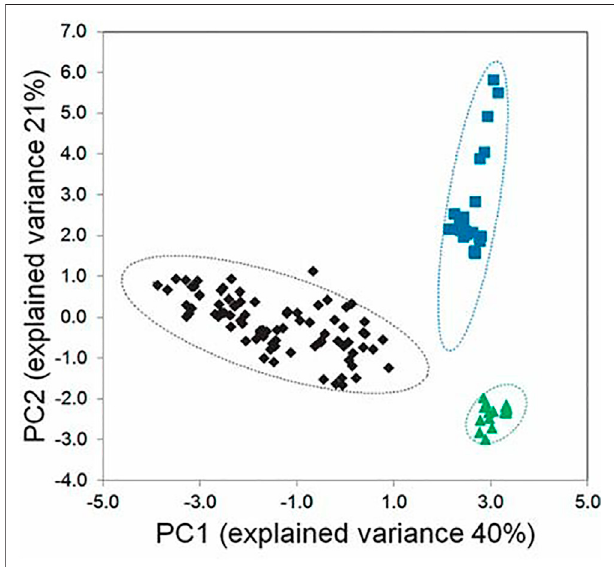
FIGURE 2 | Chemometric analysis of Vaccinium species using NMR metabolomic data. Scores plot for three species, Vaccinium angustifolium (black diamonds), V. ovalifolium (blue squares), and V. macrocarpon (green triangles). Hotelling ellipses, showing the region of the 95% con fi dence limit, are shown for each group by dashed lines of the matching color. Note that spectra for each species occupy a distinct region, with no overlap. Reproduced ( Figure 2 ) with permission from Markus, M. A., Ferrier, J., Luchsinger, S. M., Yuk, J., Cuerrier, A., Balick, M. J., & Colson, K. L (2014). Distinguishing Vaccinium species by chemical fi ngerprinting based on NMR spectra, validated with spectra collected in different laboratories. Planta medica, 80(08/09),